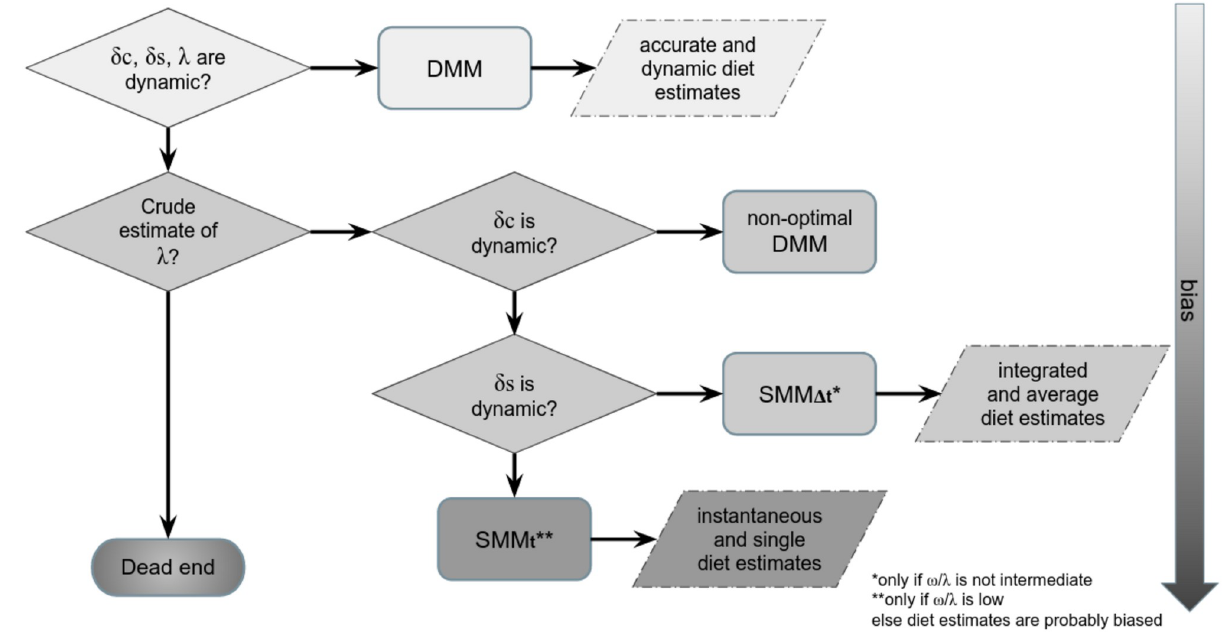
Fig 7. Decision tree of the most suitable method for estimating source proportions to the diet of one consumer considering the dynamics of λ and δ values, to reduce the bias induced by the isotopic equilibrium assumption. The diagram highlights the key aspects to be considered on the estimation of λ , the sampling of consumer and food source dynamics in order to determine which model can be applied (SMMs or DMMs).